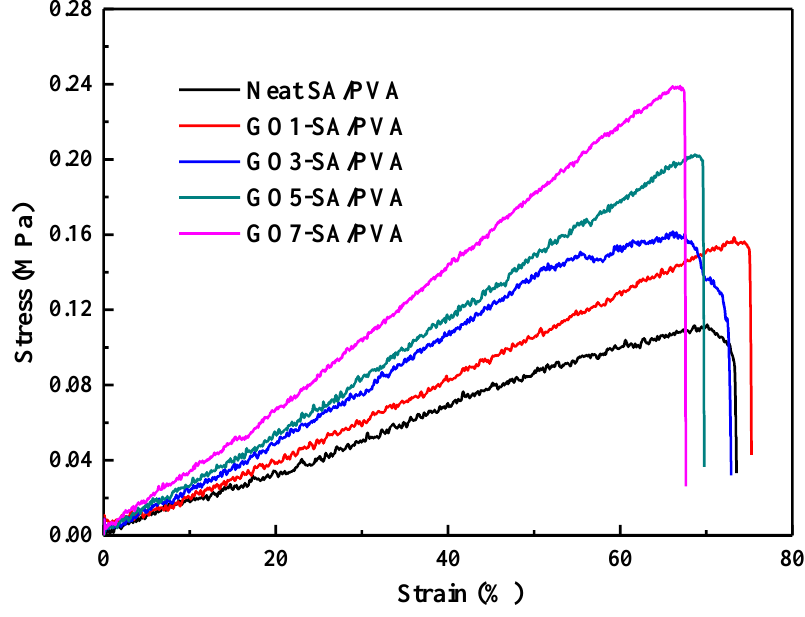
Figure 6. Stress-strain curves of neat DN hydrogel and GO reinforced DN hydrogels.